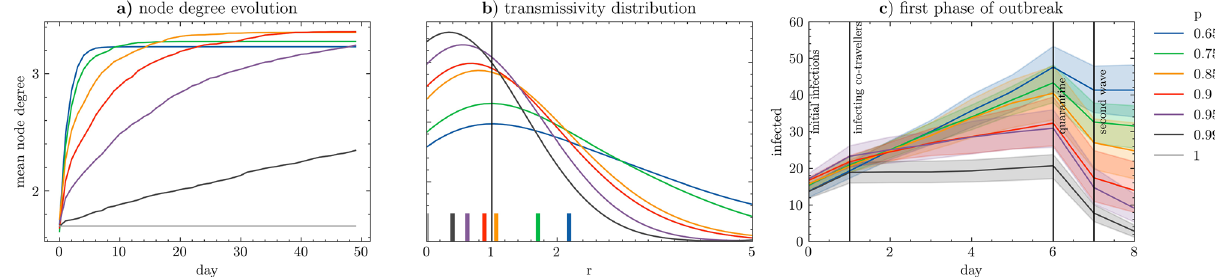
Figure 5. ( a ) Average node degree in the evolving contact networks. Regardless demand stability p , an average traveller is linked to 1.7 other travellers each day. Yet if the demand is unstable it evolves, after 10 days it reaches 1.9 if p = 0.99 , 2.5 if p = 0.95 and goes beyond 3 if p < 0.8 . ( b ) Mean transmission rate r (number of